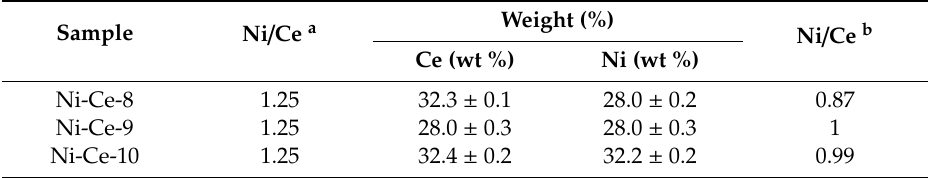
Table 1. Chemical composition of Ni-Ce-pH catalysts.